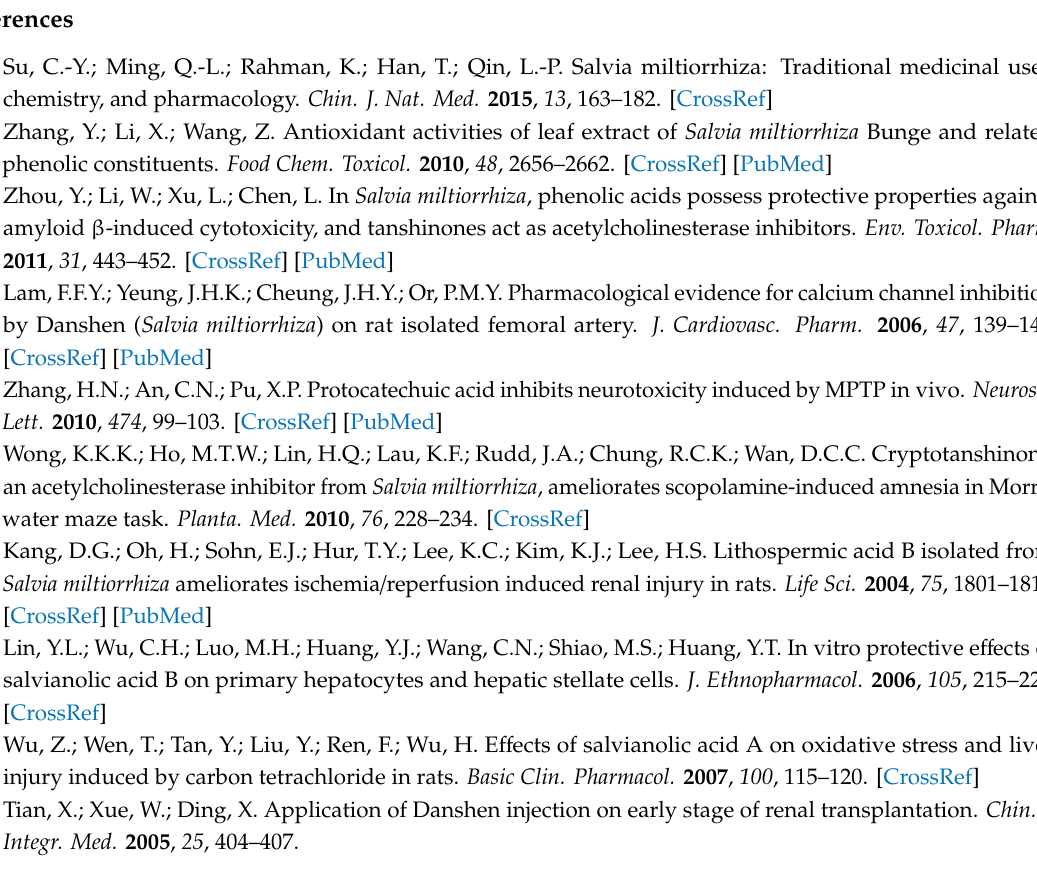
Supplementary Materials: The following: Figure S1–S3: 1 H-, 13 C-NMR spectra and HS-ESI-MS of compound 1; Figure S4–S6: 1 H-, 13 C-NMR spectra and HS-ESI-MS of compound 2; Figure S7–S9: 1 H-, 13 C-NMR spectra and HS-ESI-MS of compound 3; Figure S10–S12: 1 H-, 13 C-NMR spectra and HS-ESI-MS of compound 4; Figure S13–S15: 1 H-, 13 C-NMR spectra and HS-ESI-MS of compound